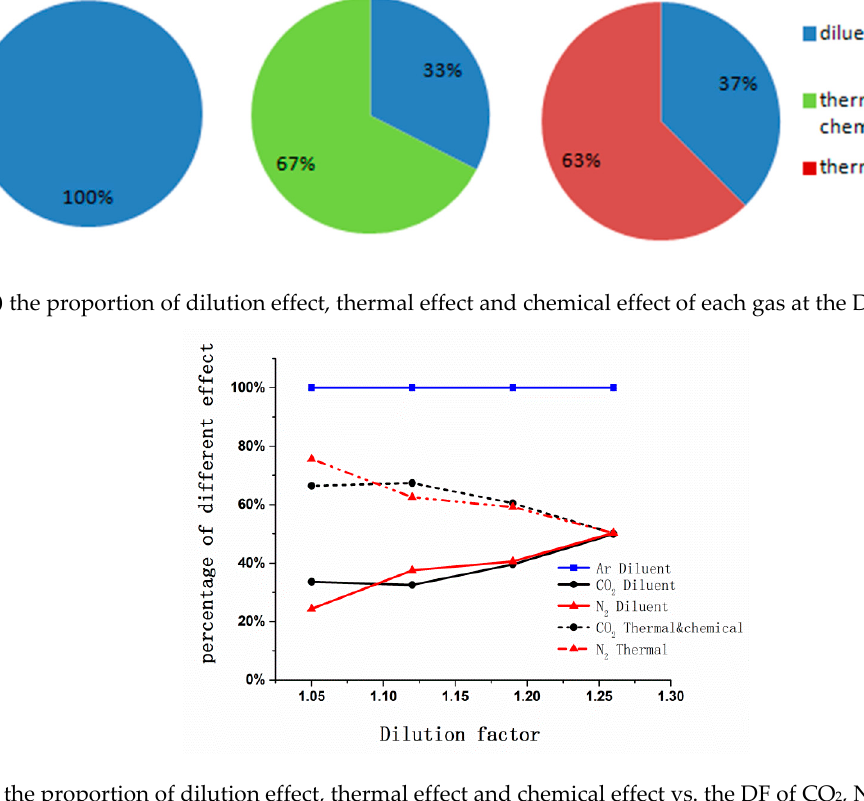
Figure 12. The proportion of different effects.